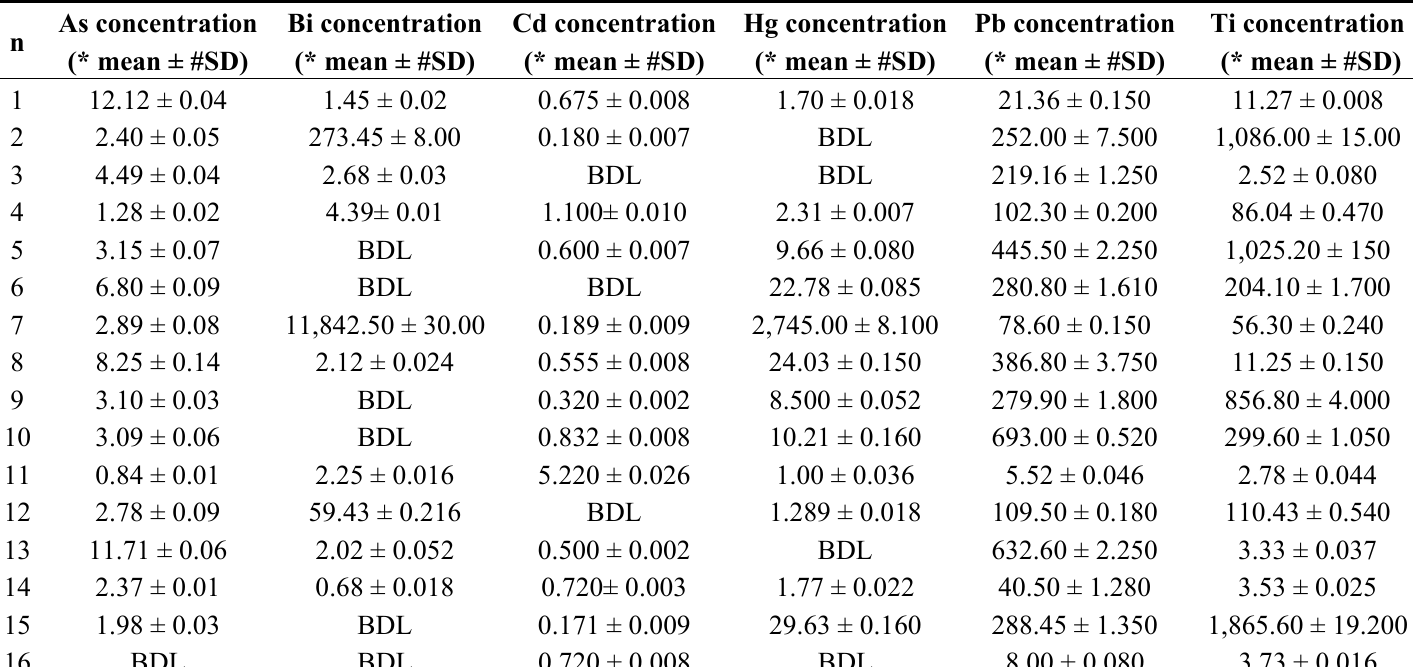
Table 8. Heavy metals content in skin whitening cosmetic products (µg·g − 1